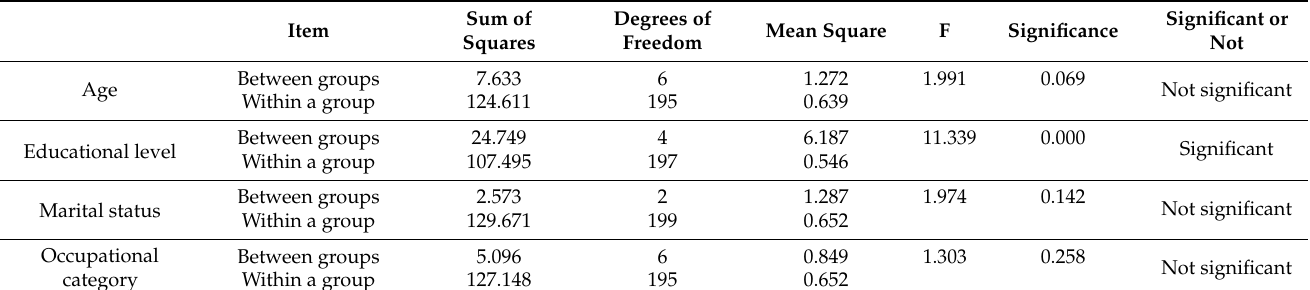
Table 11. ANOVA analysis of external variable perceived ease of use.